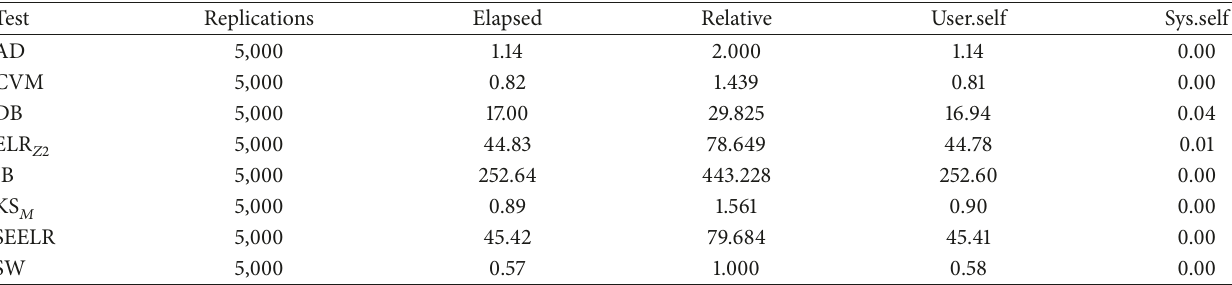
Table 1: Comparisons of computational times (in seconds) for the studied tests.